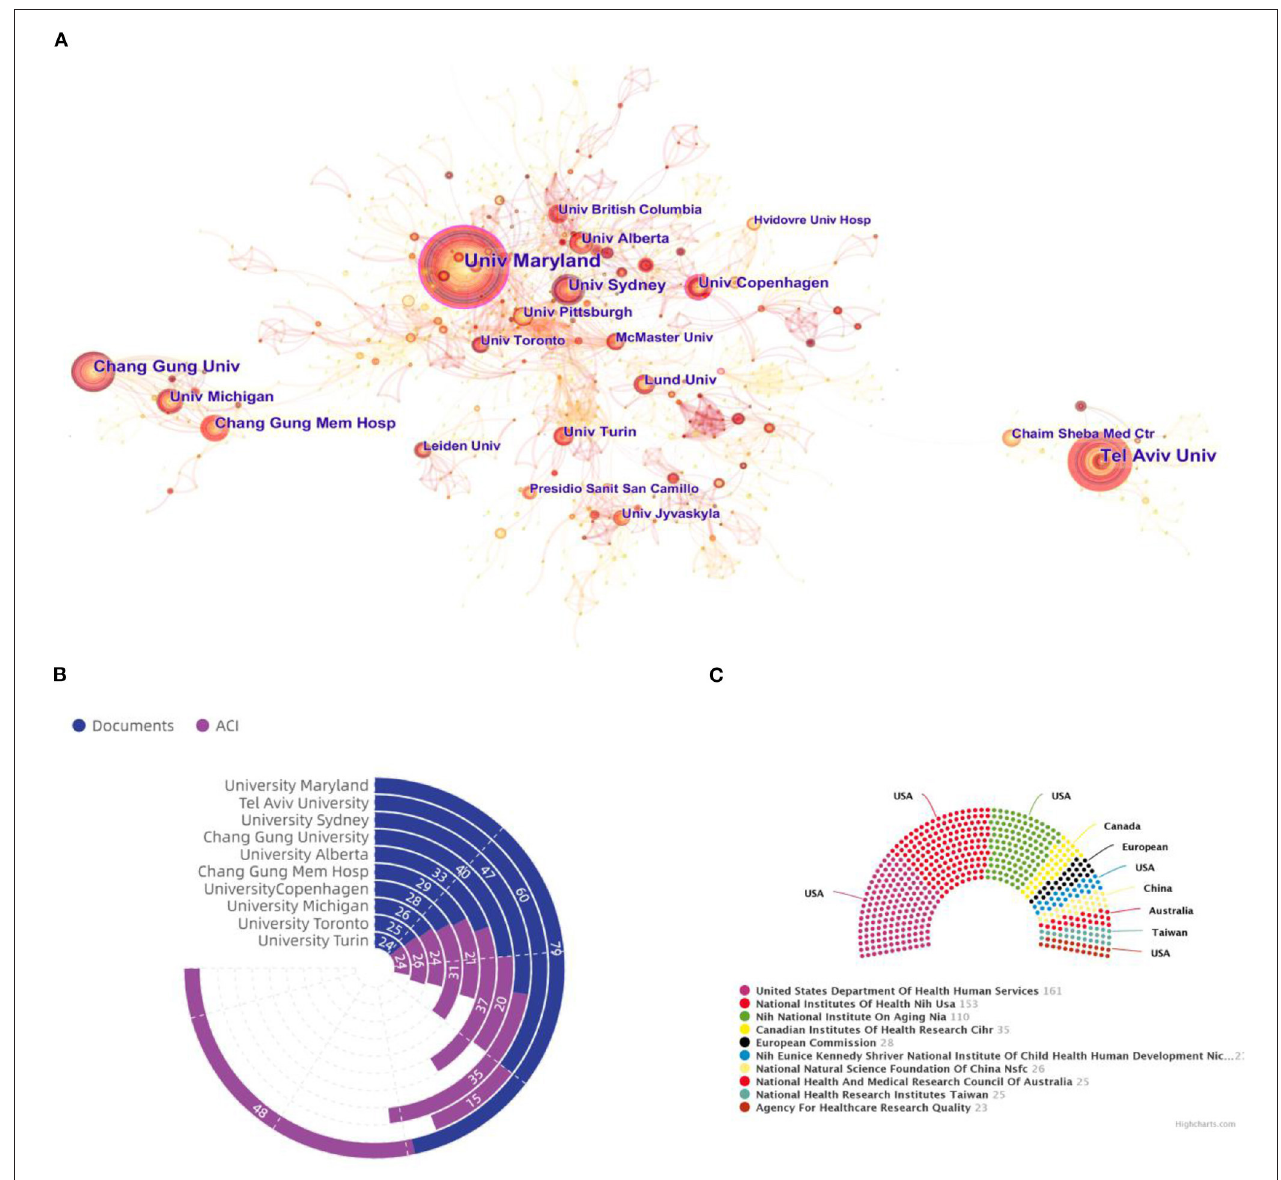
FIGURE 3 | (A) Cooperation visualization map of the rehabilitation of hip fracture research network was generated by CiteSpace. (B) The document counts and ACI of the top 10 most institutions. (C) The top 10 most active funding agencies for research on rehabilitation of hip fracture.